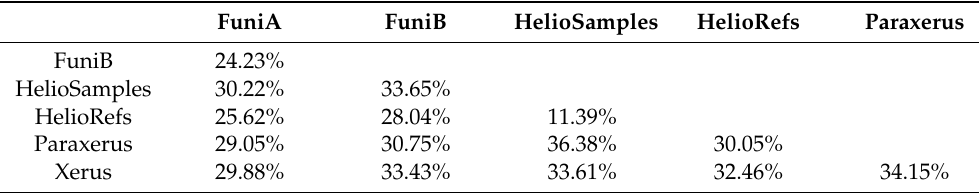
Table 4. Genetic distances as calculated by MEGA6 using the Kimura2 model of molecular evolution for squirrels sampled in Tshuapa Province, the Democratic Republic of the Congo, 2012–2015. FuniA represents Funisciurus sequences from clade A on Figure 3, FuniB represents Funisciurus sequences from clade B on Figure 3, HelioSamples represents Heliosciurus samples sequenced in this study and HelioRefs represents Heliosciurus sequences obtained through